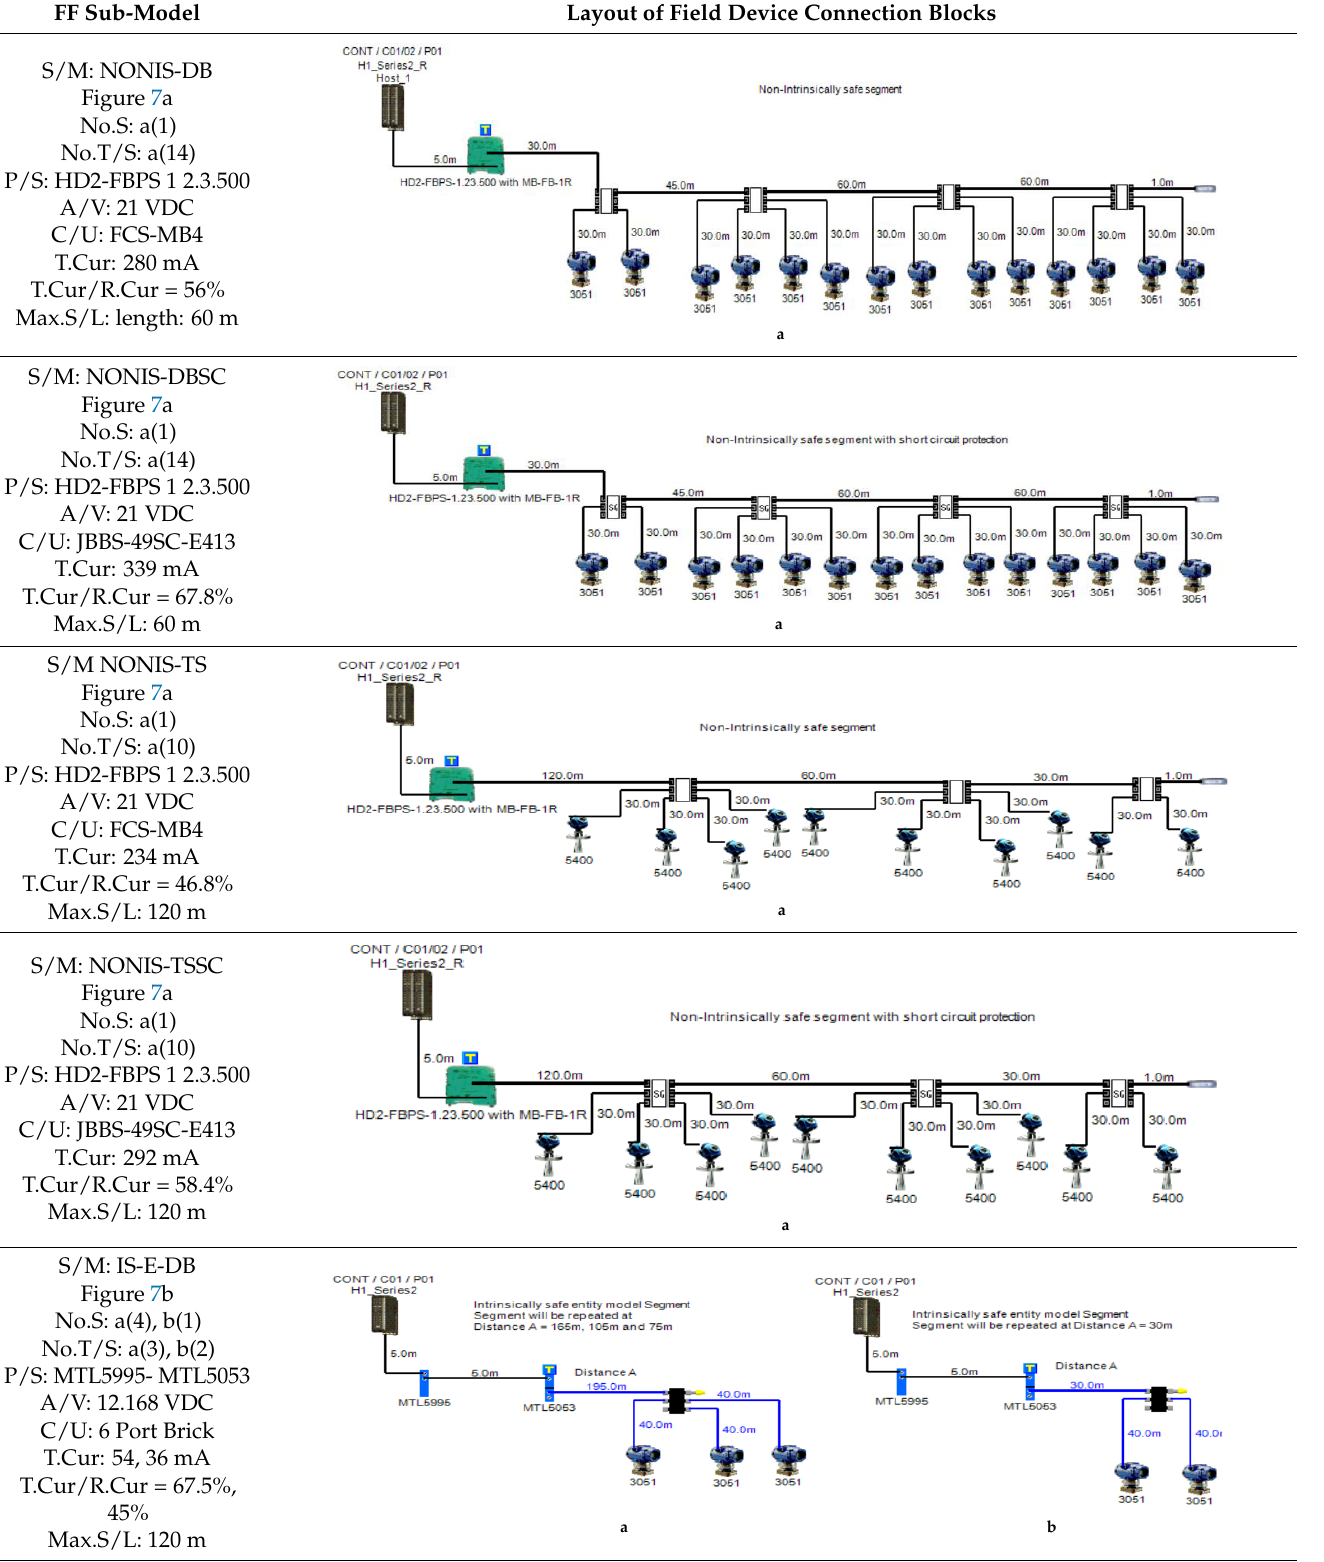
Figure 7. Layout of field device connection blocks for FF models. Connections units used differ according to the model (megablocks, megablocks with SC protection, field barriers or segment protectors). DB and TS refer to double bottom and top side tanks, respectively. S and P refer to starboard and port sides of the ship, respectively. Letters a and b on each layout refer to segments included in each sub-model as indicated in Table 1. ( a ) Non-intrinsically safe and HPTC model. ( b ) Intrinsically safe entity model. ( c ) Intrinsically safe FISCO IIB model. ( d ) Intrinsically safe FISCO IIC model. ( e ) Intrinsically safe FISCO IIB SC model. ( f ) Intrinsically safe FNICO IIB model. ( g ) In- trinsically safe FNICO IIB SC model. ( h ) Intrinsically safe FNICO IIC model. ( i ) Intrinsically safe FNICO IIC SC model. ( j ) Intrinsically safe DART model. Table 1. Connection layout for each of the proposed Foundation Fieldbus models. Type of cables used in all models is FF type A 0.8 mm 2 (18 AWG). S/M (Sub-Model), No.S (No. of segments), No.T/S (No. of Transmitters/Segments), P/S (Power Supply), A/V (Available Voltage), C/U (Con- nection Unit), T.Cur (Total Current Consumption), R.Cur (Rated Current), Max.S/L (Maximum Spur Length).